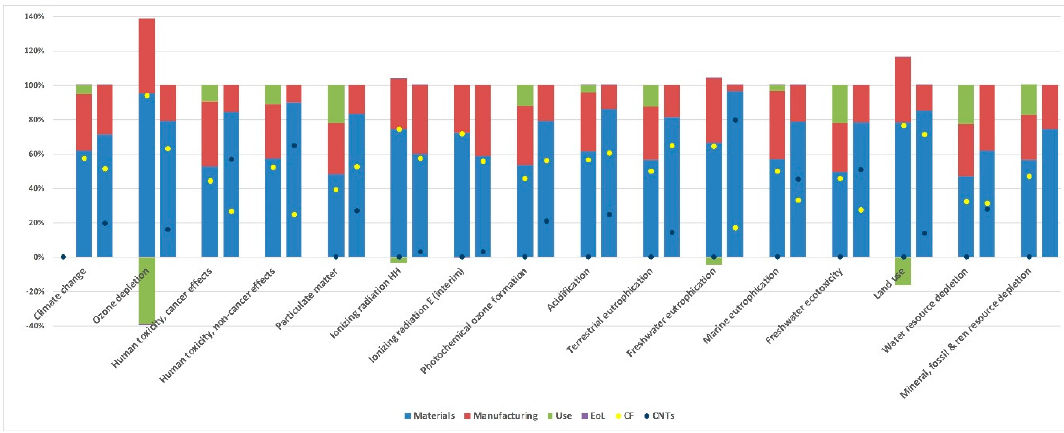
Figure 6. Percent contribution of the life cycle stages and of the main raw materials for the two studied cases. CNT, carbon nanotube.